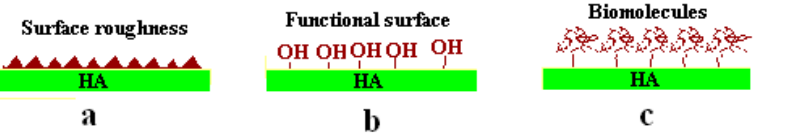
Figure 2. Strategies for surface modifications of nHA by ( a ) roughness; ( b ) functionality; ( c ) deposition of biomolecules.